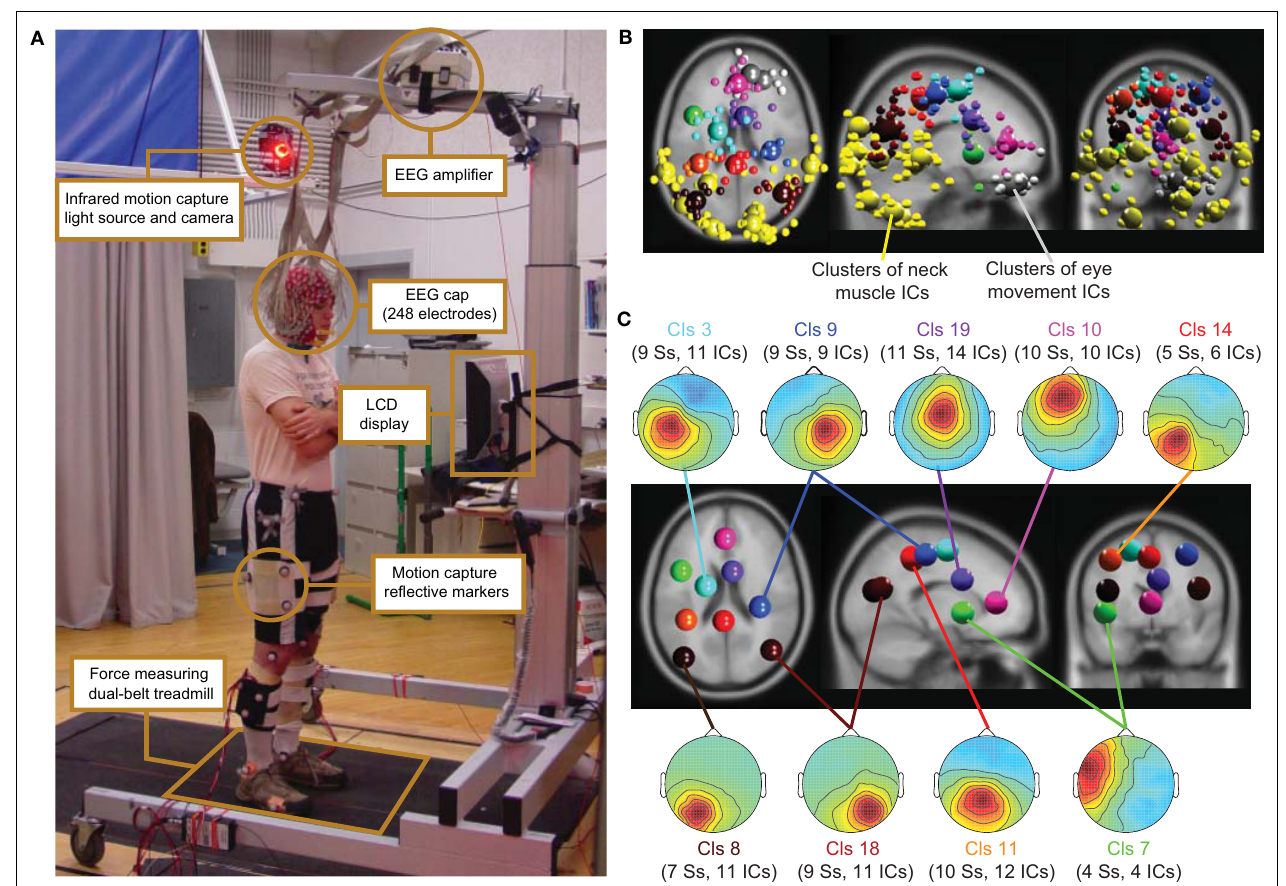
views of the standard MNI brain. (Yellow) Neck-muscle ICs; (gray) eye- movement ICs; (other colors) brain-based ICs (C) (Scalp maps) Mean projections to the scalp of the indicated brain-based IC clusters. Labels give the index (Cls #), number of subjects (Ss), and number of independent components (# ICs) for each